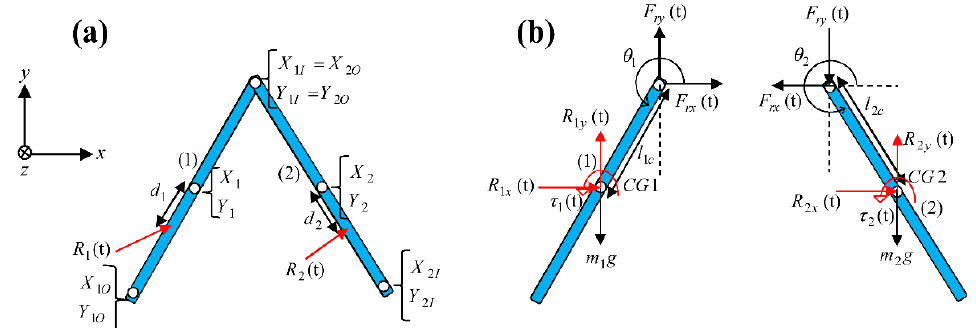
Figure 2. ( a ) Two-link mechanism with a revolute joing. ( b ) Free-body diagram of the internal